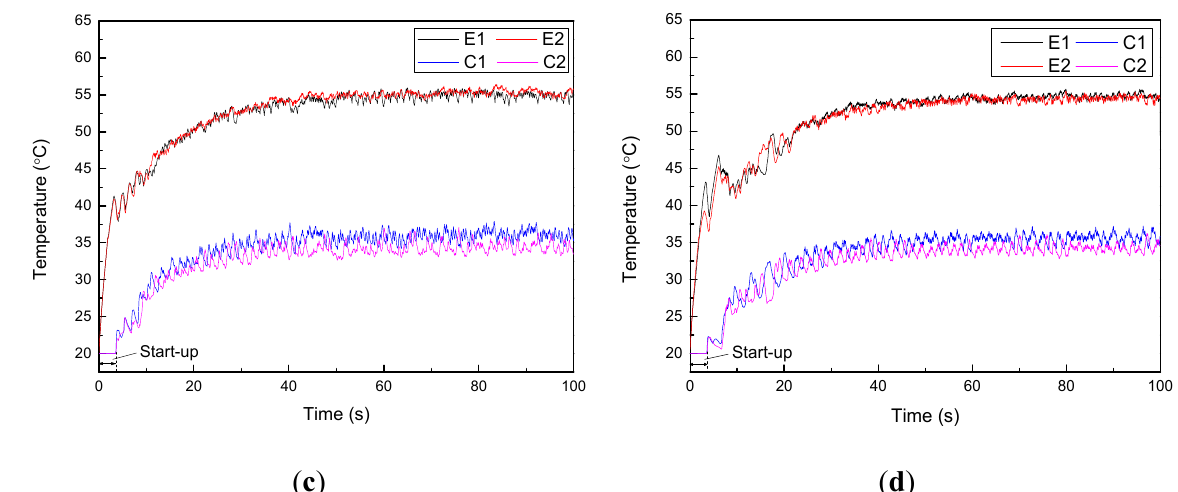
Figure 12. The temperature fluctuation of the PHP at 40 W with different lengths of the adiabatic section: ( a ) 60 mm, ( b ) 120 mm, ( c ) 180 mm, and ( d ) 240 mm.